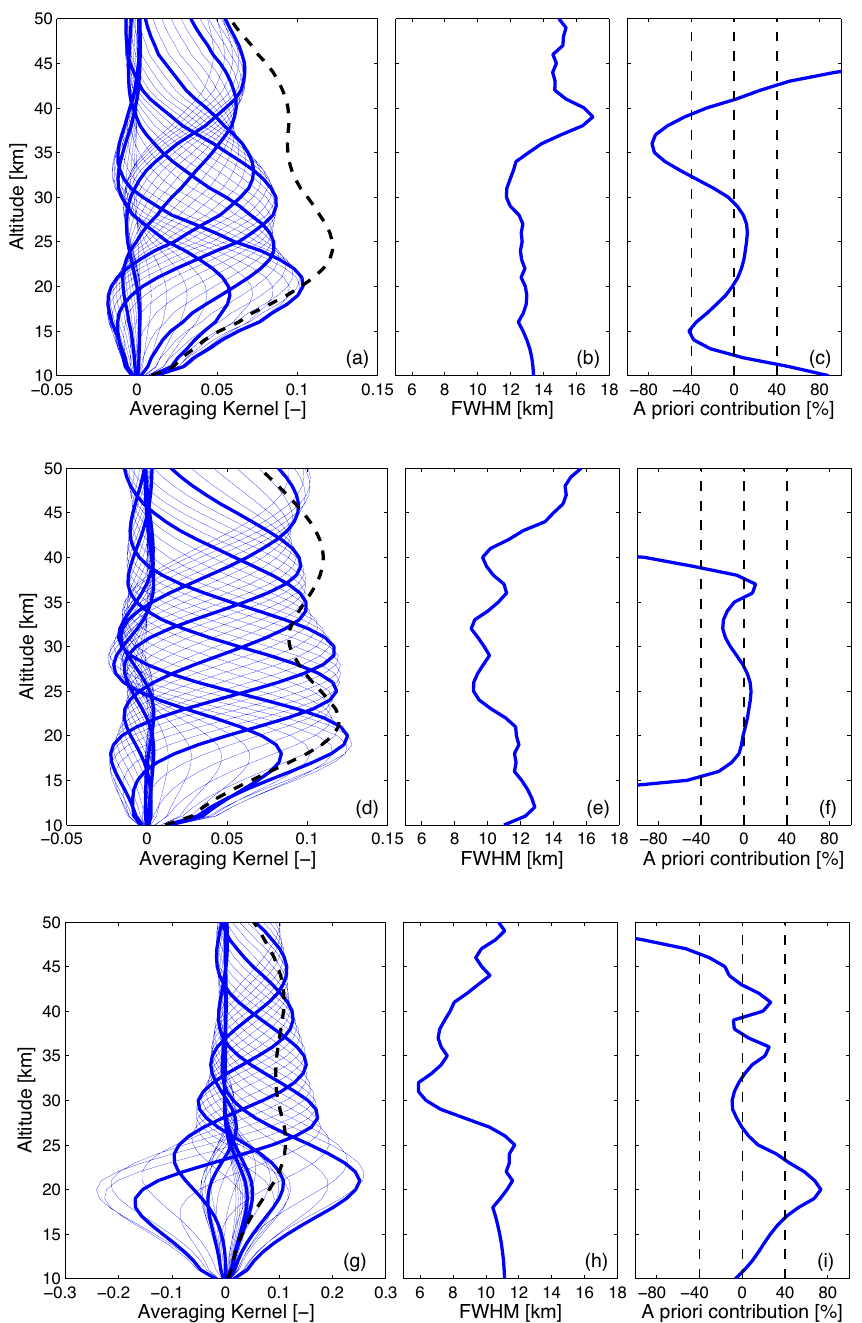
Fig. 3. GBMS averaging kernels ( a , d , and g ), retrievals vertical resolution ( b , e , and h ), and a priori contribution ( c , f , and i ) for three different cases: winter mid-latitudes observations at Testa Grigia (panels a – c ), high-latitude observations at South Pole during fall (panels d – f ) and winter (panels g – i ). The three sets of AKs are obtained with σ a ∼ 1.5ppbv and values of σ ε of 2 . 5 × 10 − 3 (panel a ), 2 . 5 × 10 − 4 (panel d ), and 1 . 25 × 10 − 5 (panel g ). In panels (a) , (d) , and (g) , thicker blue lines are averaging kernels calculated each 5km, from 15 to 45km, whereas dashed black lines represent the total sensitivity, as defined in the text, divided by 10.